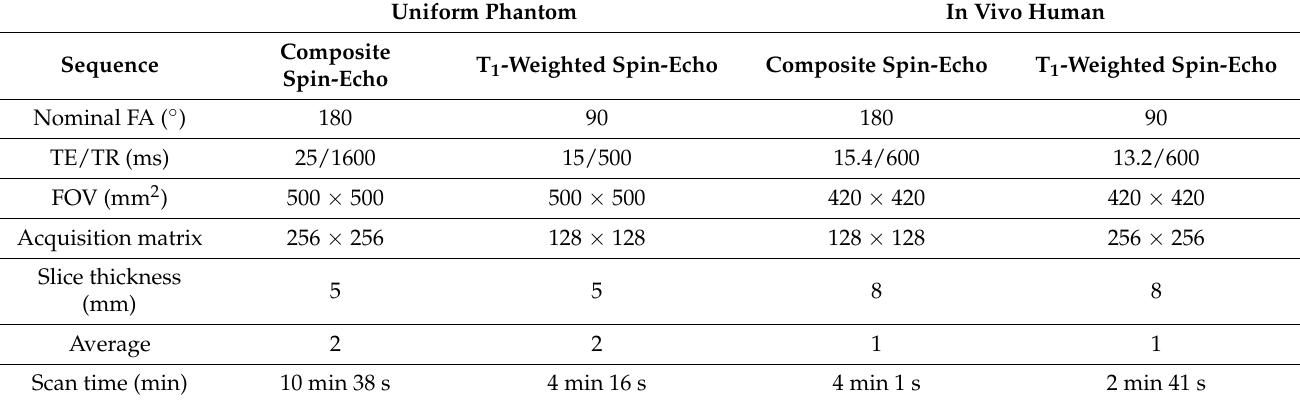
Table 1. MR sequence parameters.